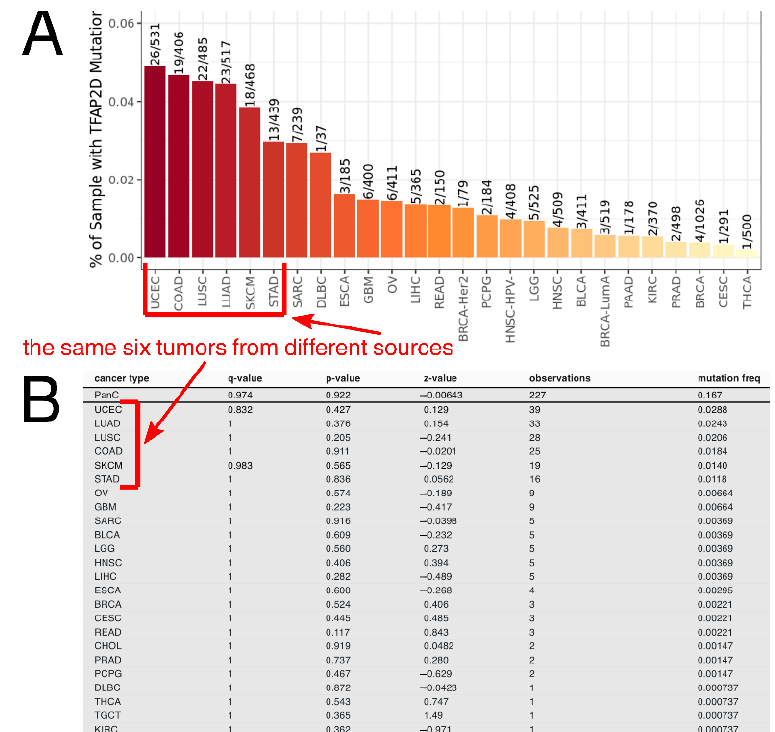
Figure 6. TFAP2D mutation frequency across tumors according to TIMER ( A ) and FABRIC ( B ). The same six tumors having the highest mutation frequency (i.e., UCEC, COAD, LUSC, LUAD, SKCM, STAD) are marked with red frames and arrows.